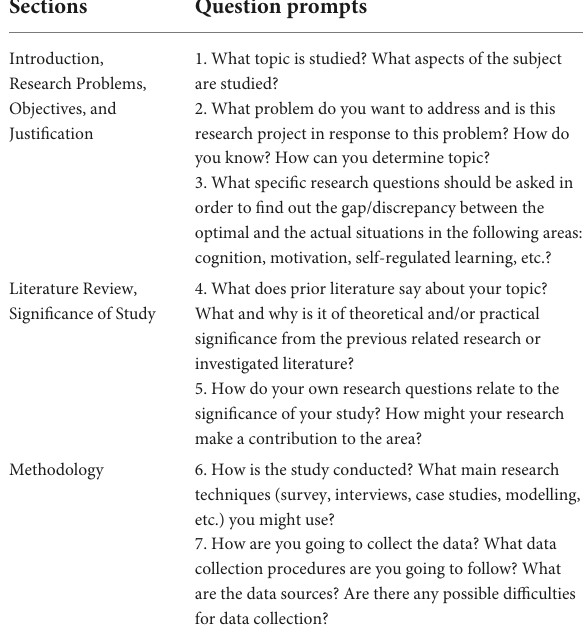
FIGURE2 The learning groups.